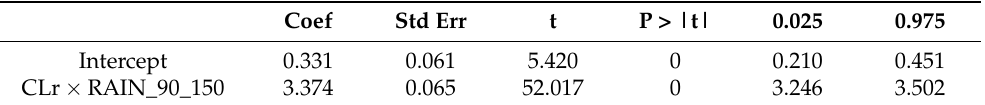
Table 6. Summary of model fit using the linear least-squared method from Statsmodels python tool. The table shows the coefficients of the linear model and their statistical significance. Coef Std Err t P > |t|